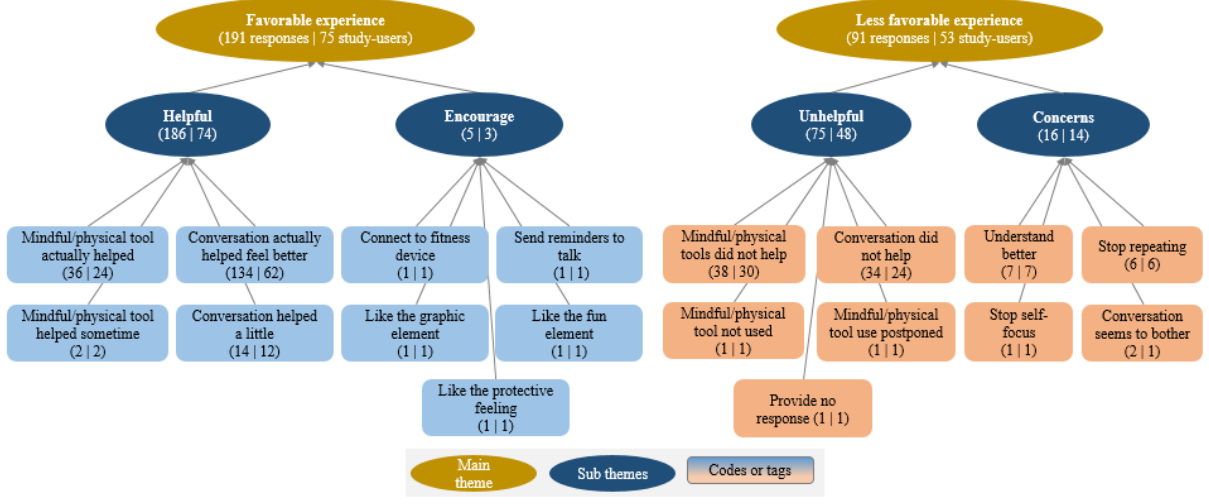
Figure 2. Thematic map with